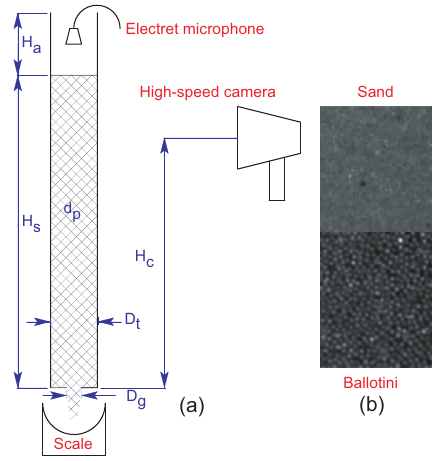
Figure 2. (a) A schematic of the experimental setup, and (b) images of grains taken by the camera (top, 0.15-0.25mm sand, below, 0.3-0.4mm